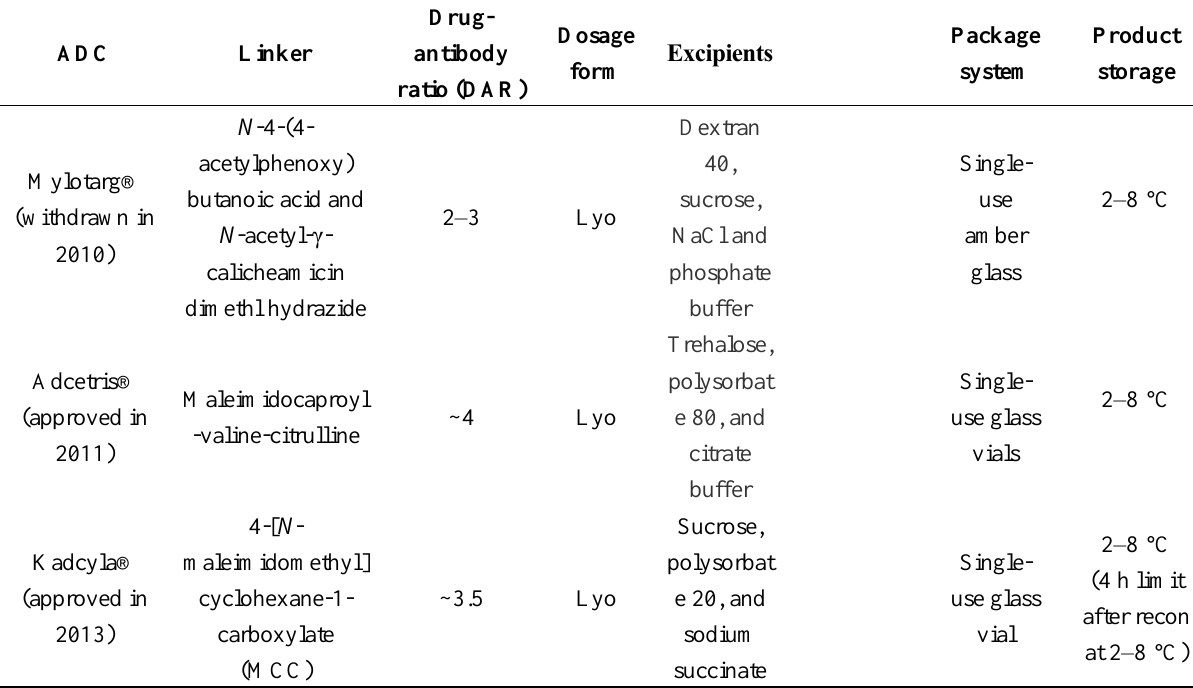
Table 2. Information on currently available commercial antibody drug conjugates